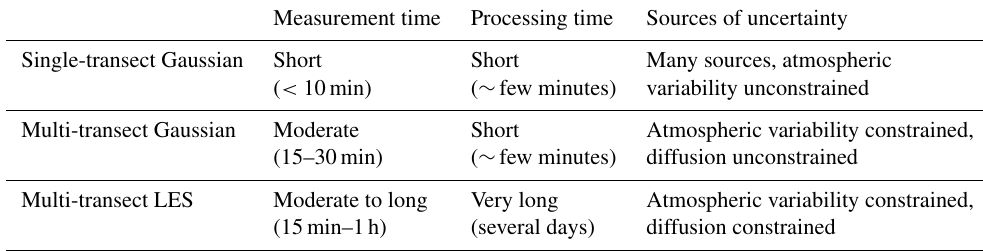
Table 8. Summary of advantages and disadvantages of each